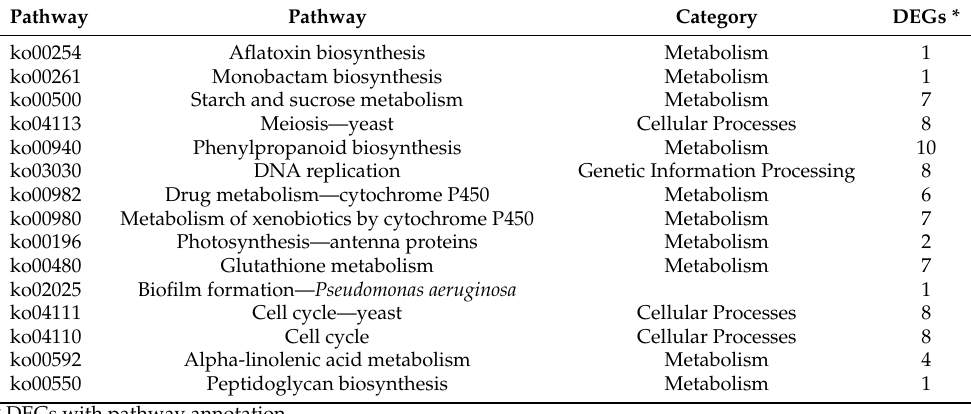
Table 2. Significantly enriched fifteen pathways from both up- and downregulated differentially expressed genes (DEGs) between control and cold treatment at 0 ◦ C for 10 days in strawberry.